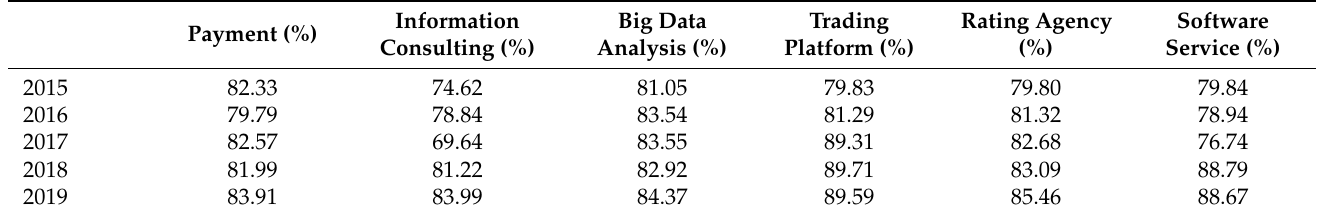
Table 13. The annual changes in the similarity of risk factors in the fintech sub-industries.